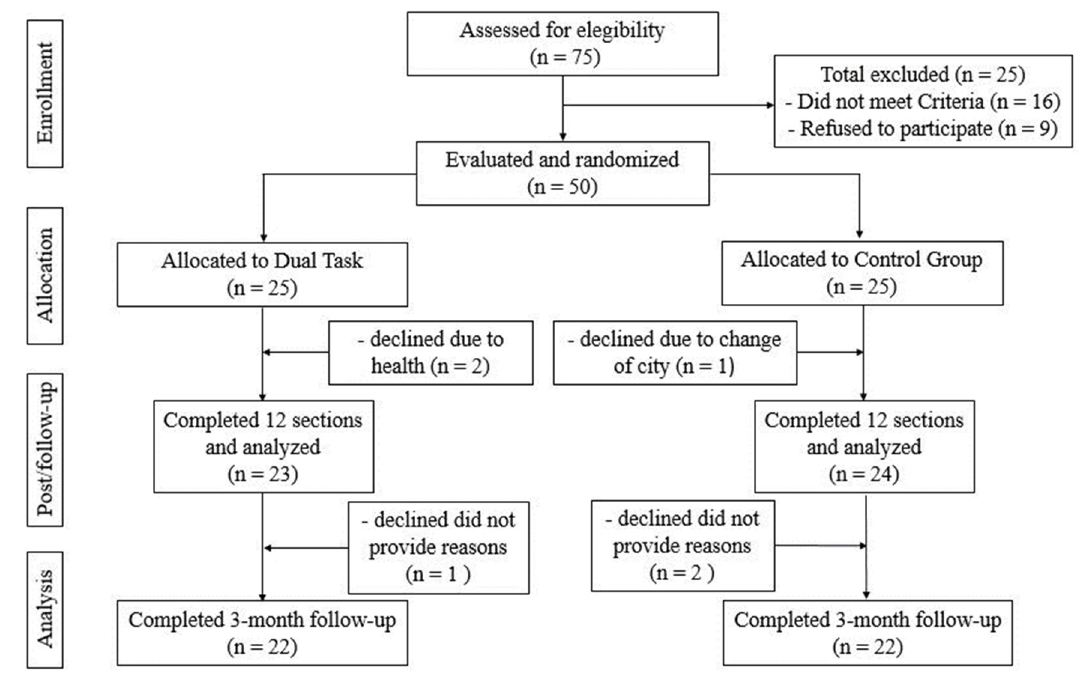
Figure 1. Study design and flow of participants.